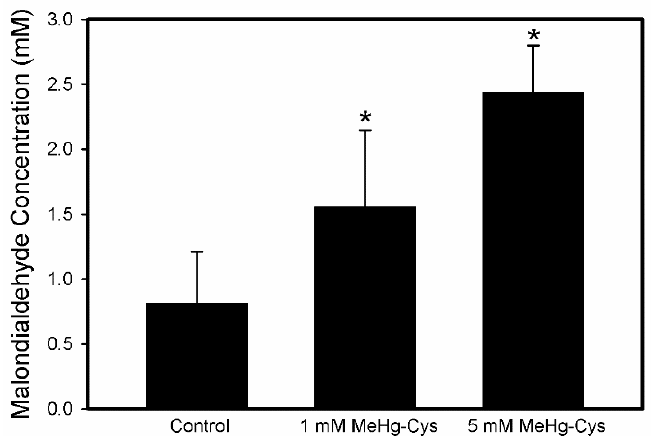
Figure 8. Lipid peroxidation in BeWo cells exposed to MeHg-Cys. BeWo cells were exposed to 1 mM or 5 mM MeHg-Cys for 30 min at 37 °C. Results are presented as mean ± SE. Data represent 3 experiments performed in triplicate. *, significantly different ( p < 0.05) from unexposed cells.